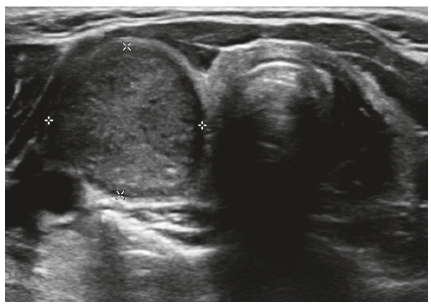
Figure 1: Thyroid ultrasound scan shows a round well circum- scribed heterogeneous, highly vascular mass arising from the right lobe of the thyroid, measuring 21 x 17 x